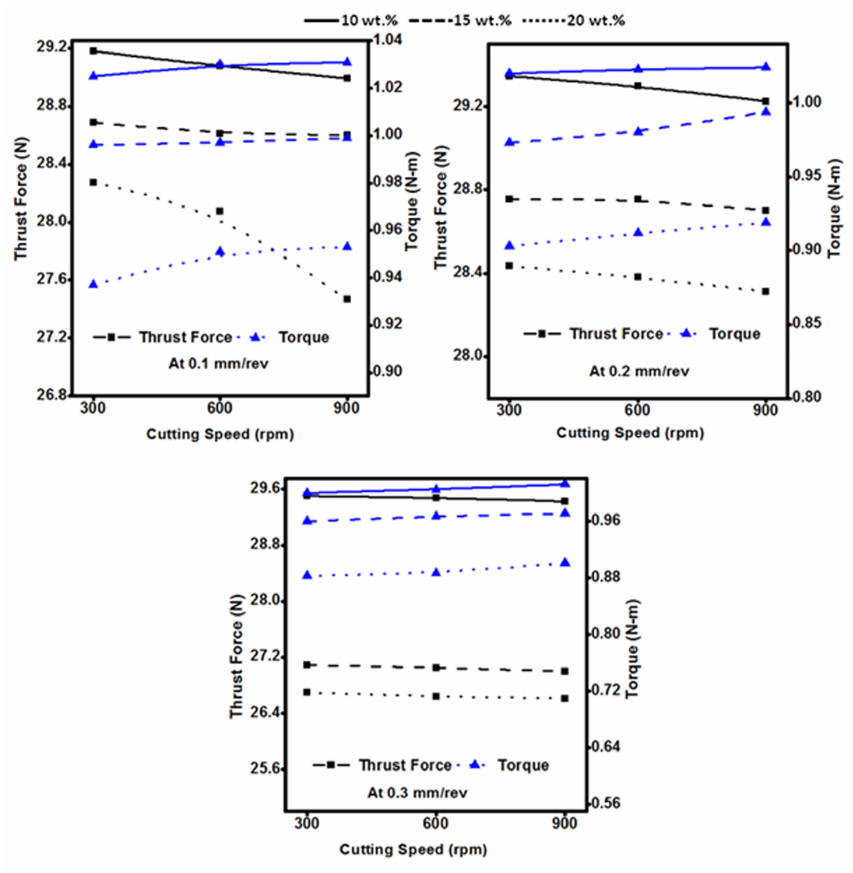
Figure 7: Effect of cutting speed, wt.% and feed rate on thrust force and torque for RH reinforced composites